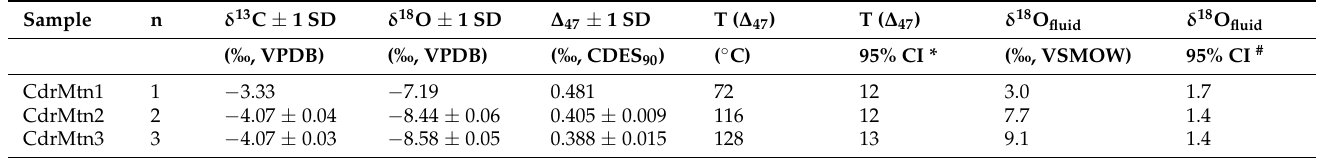
Table 4. Carbonate clumped isotope measurement